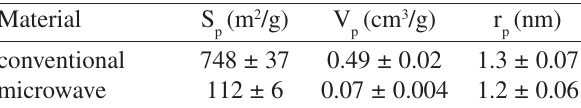
Table 2. Structural parameters of silica